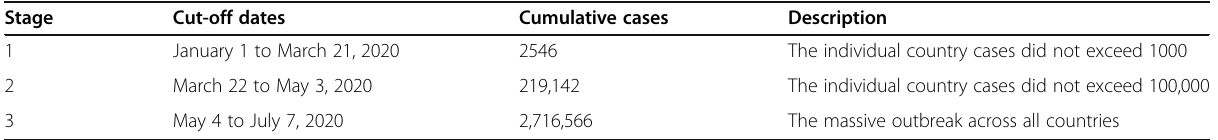
Table 3 Phases of evolution of Covid-19 in Latin America